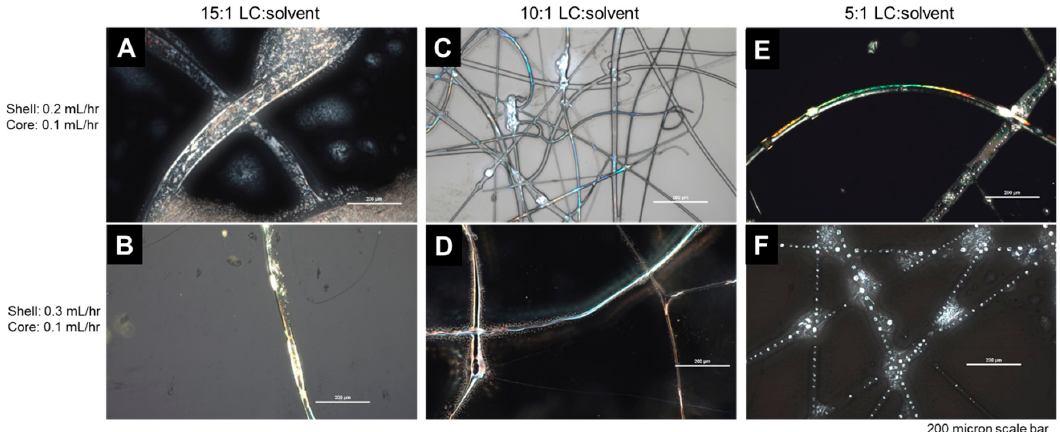
Figure 5. Polarized optical light microscopy (PLM) images of PVP fibers electrospun with